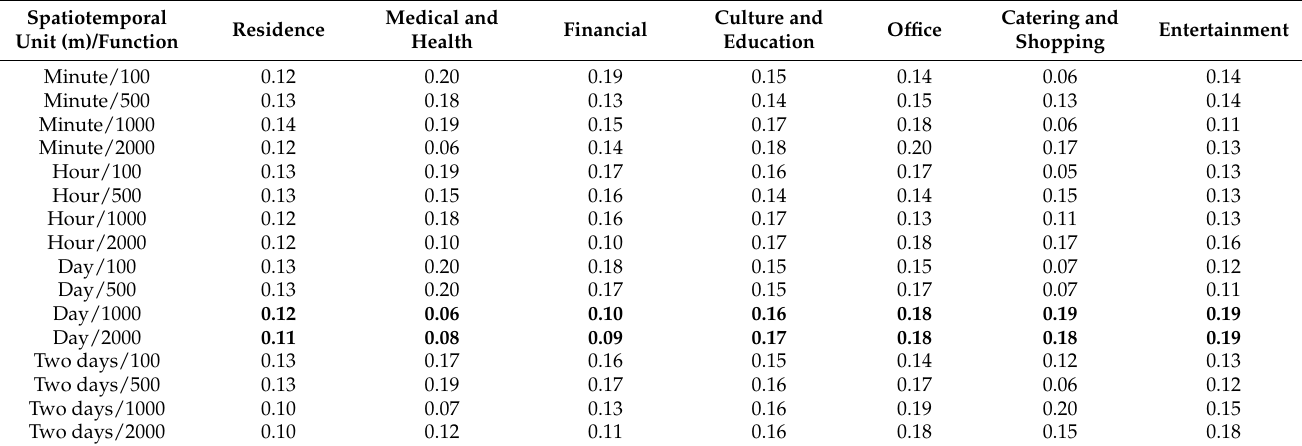
Table 7. Proportions of functional types in hotspot areas with different spatiotemporal